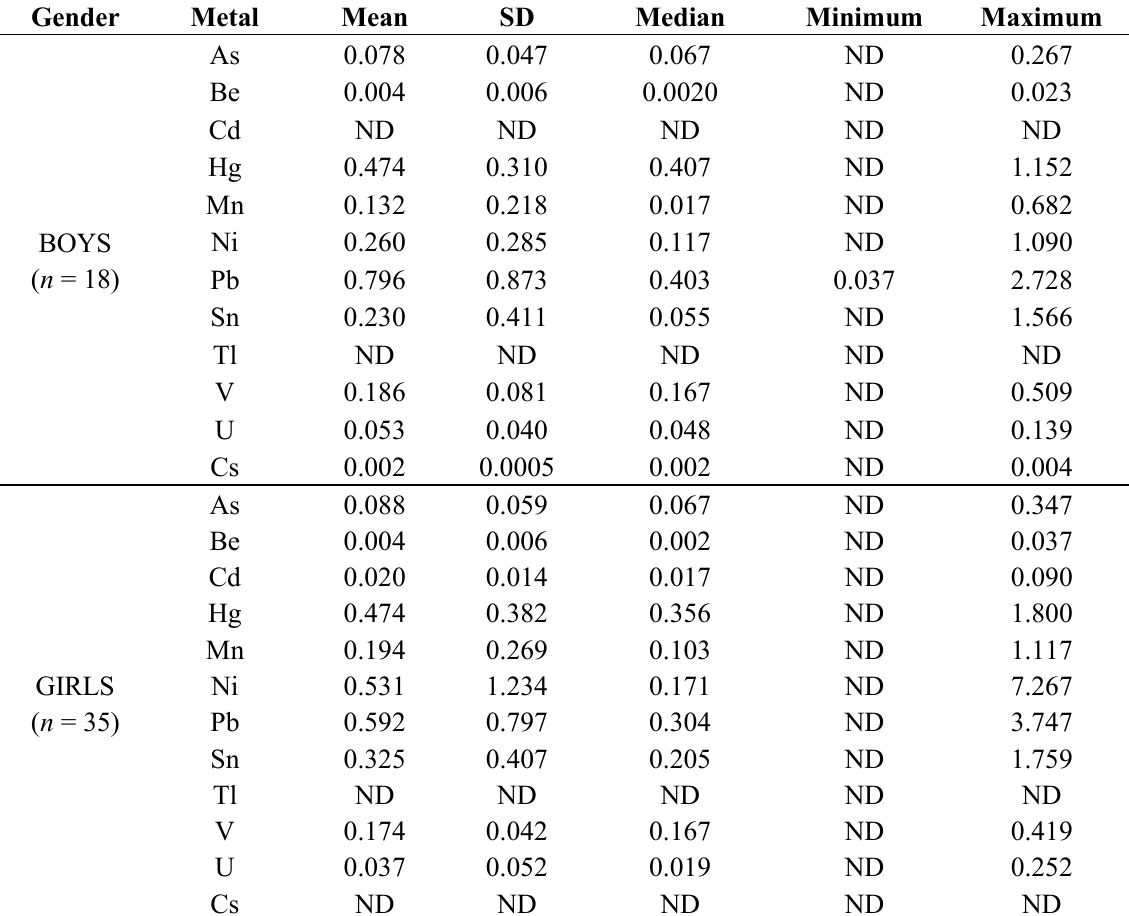
Table 1. Metal concentrations (in µg/g) in human hair of 53 children of Flix, according to gender.